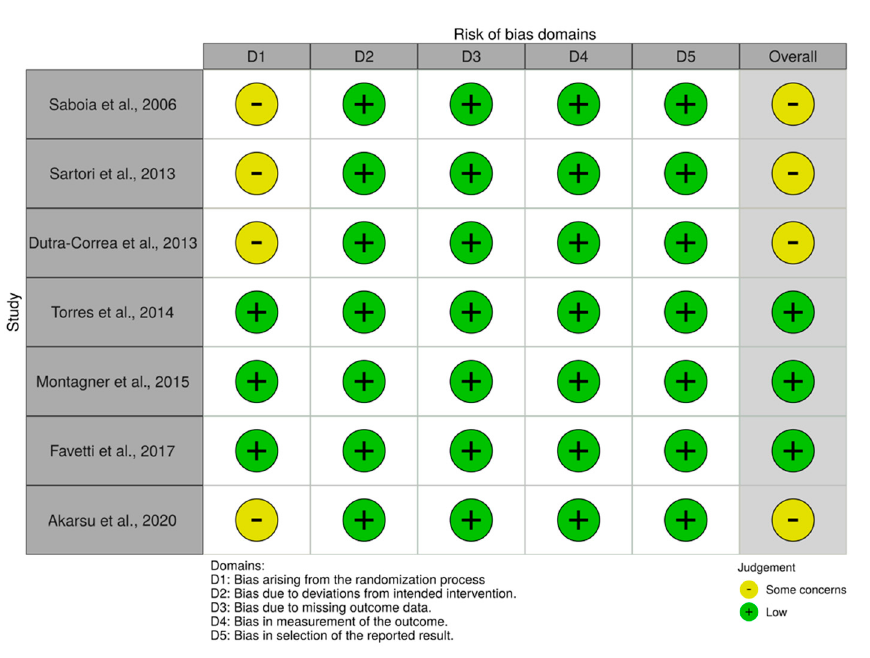
Figure 2. Methodological quality assessment of the included clinical (RCT) using the Revised Cochrane risk-of-bias tool for randomized trials (RoB 2).